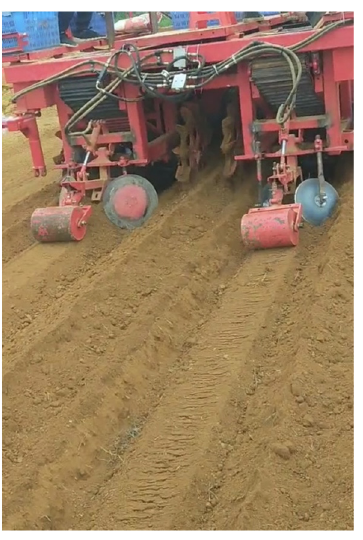
Figure 10. The field test of soil thickness.